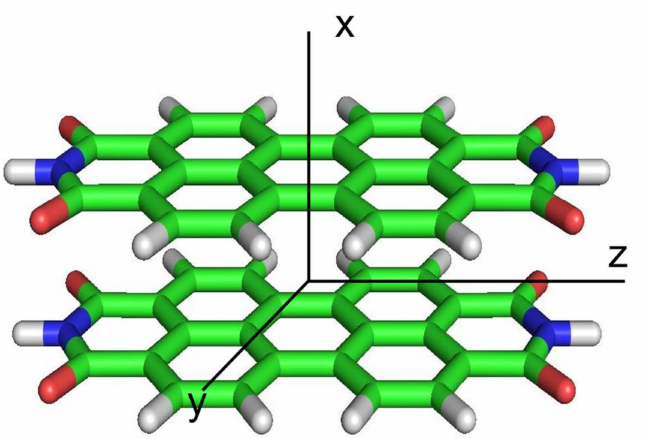
Figure 1. The PDI dimer considered in this work. Singlet and triplet exciton states have been determined at the eclipsed configuration shown here and along the interchromophore longitudinal (z-axis) translation